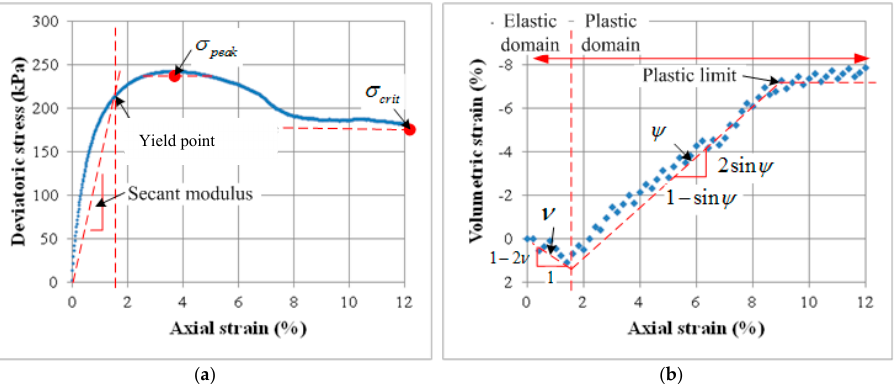
Figure 9. Global stress-strain behavior curves: ( a ) axial stress vs. axial strain, ( b ) volumetric strain vs. axial strain.